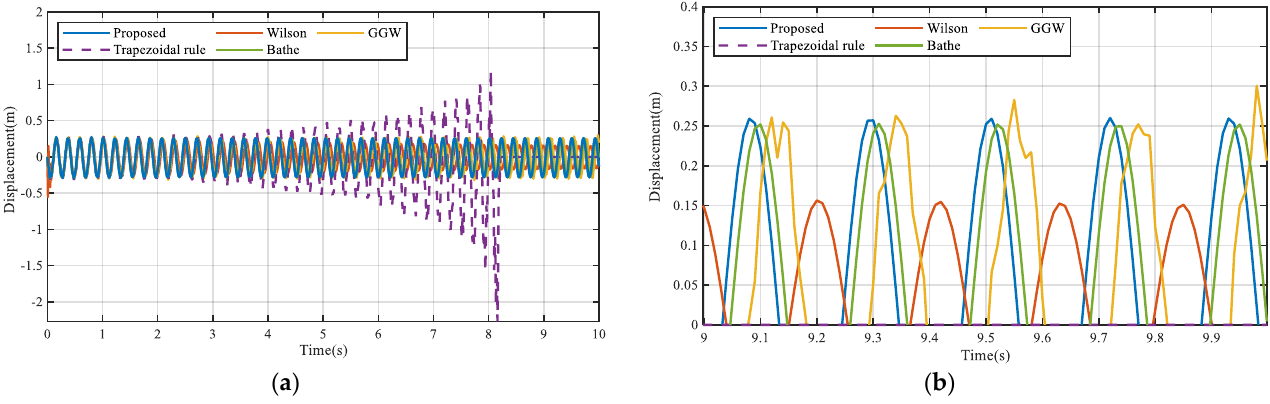
Figure 12. Long span planar skeletal structure.